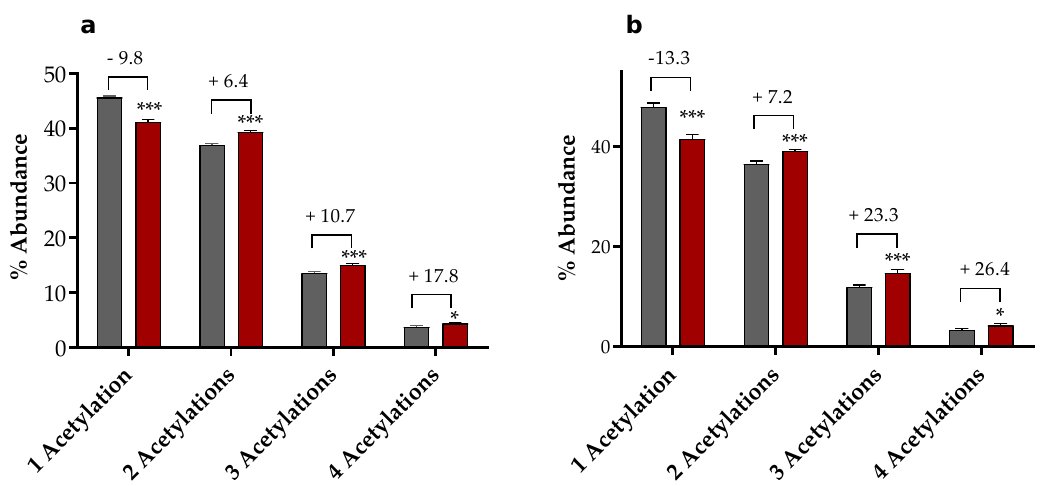
Figure 5. Compound 3 induces an increase of H4 acetylation degree. The histograms report the relative abundance of histone H4 isoforms grouped on the basis of their acetylation status obtained from the analysis of the deconvoluted ESI mass spectrum. Histones were extracted from IGROV1 cells after treatment with 3 (red) or from untreated cells (gray) for: 6 h ( a ); or 24 h ( b ). Above the bar, the percent difference between the control and compound 3 is reported. * p < 0.05, *** p < 0.001.